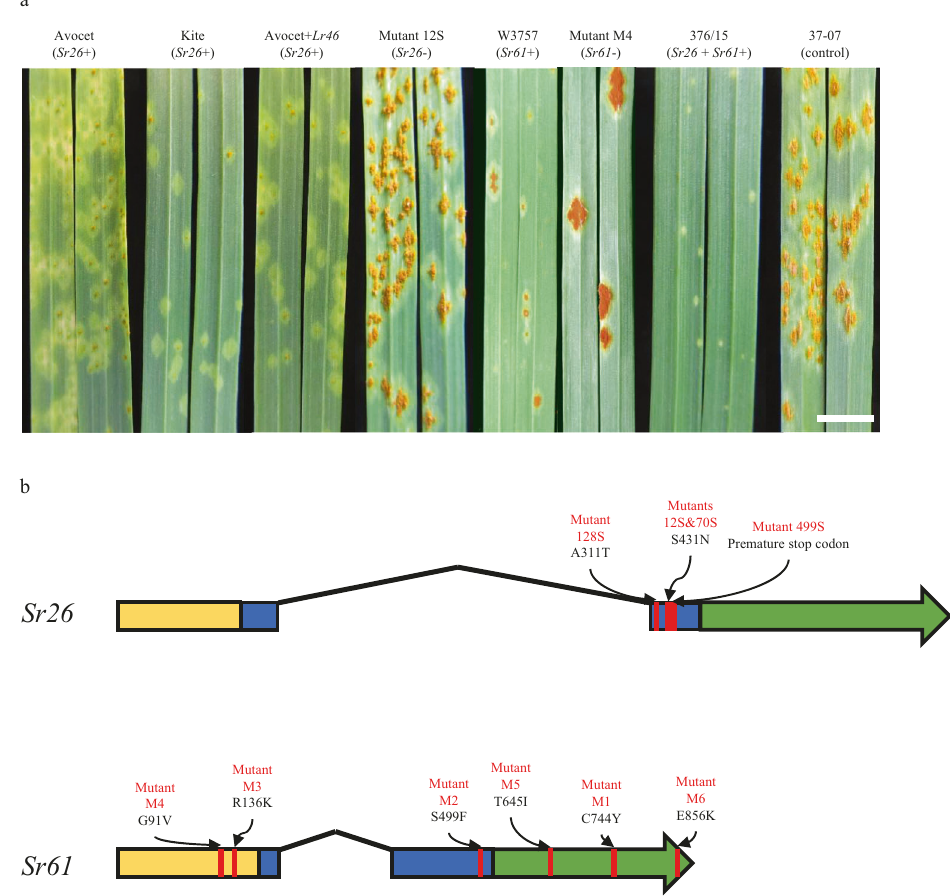
Fig. 1 Rust response phenotypes conferred by the Sr26 and Sr61 parental sources and mutant derivatives, and gene structures of Sr26 and Sr61 candidate genes. a Abaxial seedling leaf surfaces of wild-type and representative EMS-generated susceptible mutants for Sr26 and Sr61 , together with recombinant 376/15 inoculated with Pgt race PTKST. Avocet, Kite, Avocet + Lr46, W3757, and recombinant 376/15 showed low infection types (small pustules or fl ecking), whereas Sr26 mutant 12S, Sr61 mutant M4 and susceptible control line 37-07 all showed high infection types (large pustules). Bar shows 1 cm. b Gene structures of candidate Sr26 and Sr61 genes. Exons are shown as solid boxes with the terminal exon indicated as an arrow to show the direction of transcription whereas introns are shown as solid black angled lines. The position of mutations in mutant lines are shown in red with predicted amino acid substitutions caused by nonsense mutations and premature stop codon shown above. CC domain, NB domain, and LRR motifs are shaded upon the exons with yellow, blue, and green